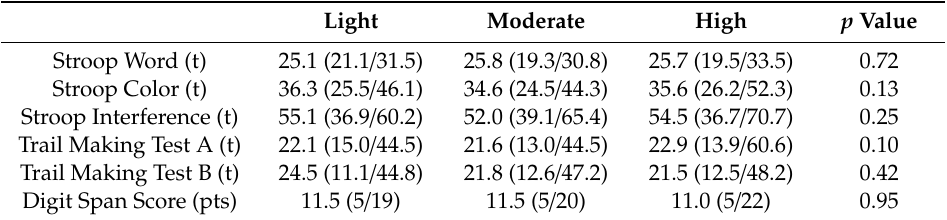
Table 2. Pre-intervention values of cognitive performance prior to the three sessions. Light Moderate High p Value